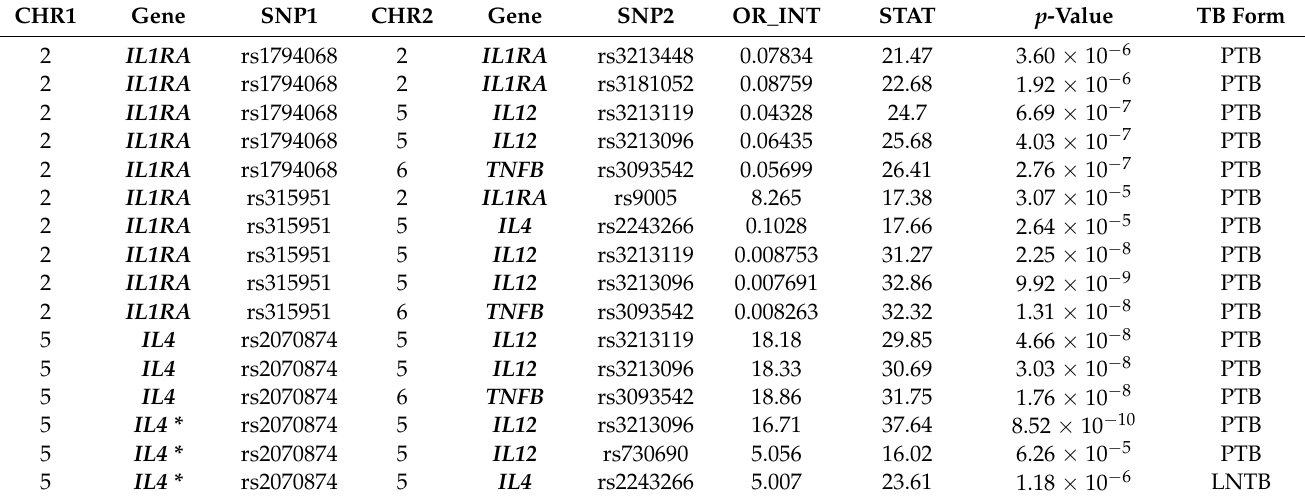
Table 4. Comparison of Epistatic interactions in cytokine genes between PTB and